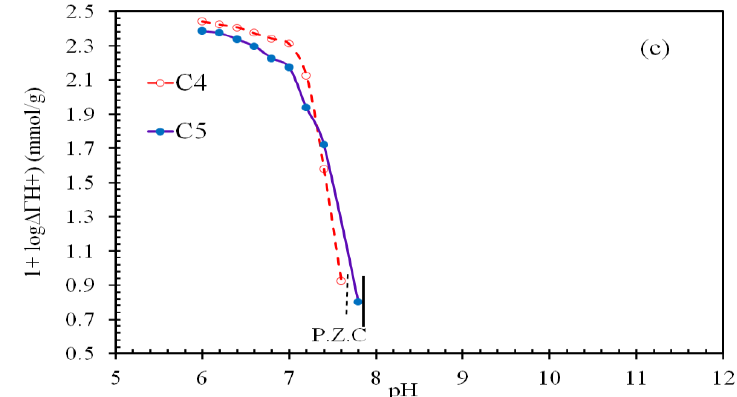
Figure 7. Dependence of log ∆Γ O − (amount of acid) and log ∆Γ H + (amount of base) on pH for ( a ) C1 and C2 clays, ( b ) C3 clay and ( c ) C4 and C5 clays.